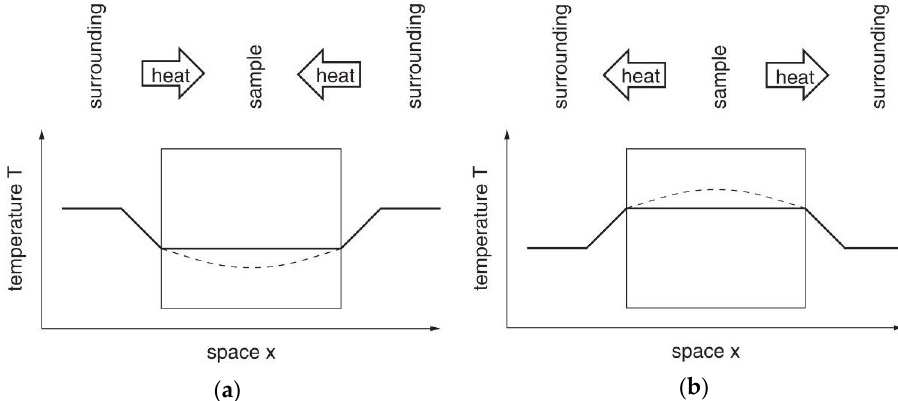
Figure 5. Schematic of the heat flow ( a ) into and ( b ) out of the sample crucible, after [45].